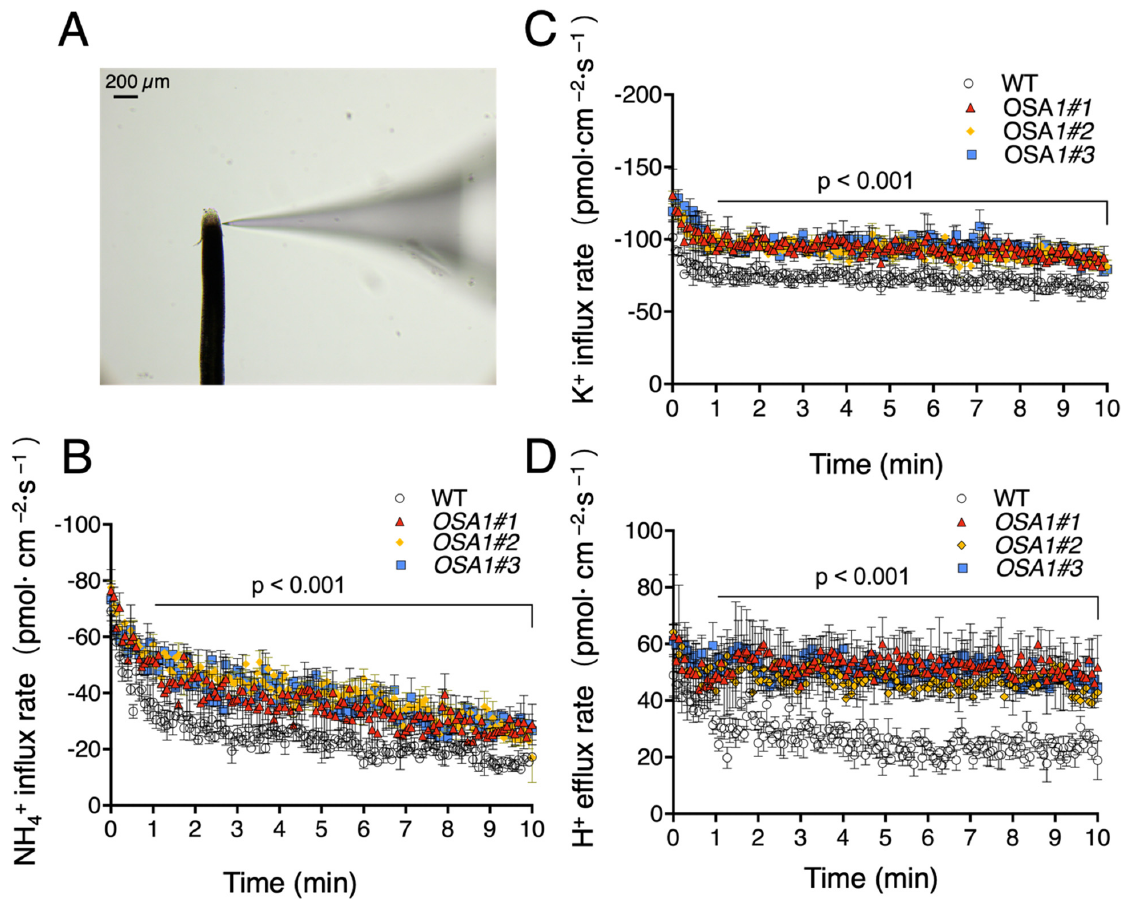
Figure 6. Quantification of NH 4+ influx, K + influx, and H + efflux rates of WT and OSA1 -oxs roots. The 5-day-old seedlings of WT and OSA1 -oxs were treated with hydroponic solution lacking NH 4+ or K + for 24 h. Intact roots were equilibrated in the measuring solution (0.1 mM NH 4+ and 0.1 mM K + are in the test solution) for 10 min. ( A ) The nutrient flux rate was measured along the root tip, around 150 µ m from the root cap. Black-colored object is a rice root and the right one is a microelectrode probe used to determine the change of ion flux in the root surface. The NH 4 + influx rate ( B ), K + influx rate ( C ), and H + influx rate ( D ) were calculated. Values are mean ± SD ( n = 3). Significant difference was evaluated using the two-tailed Student’s t